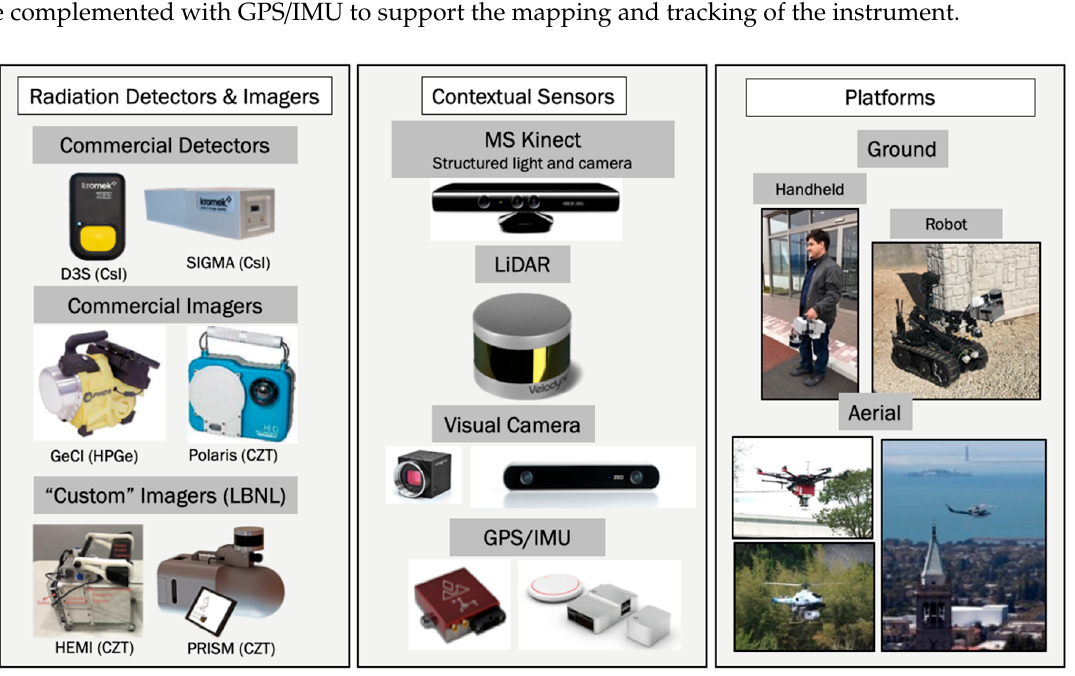
Figure 2. Examples of hardware components and platforms that can be used with the 3-D scene-data fusion (SDF) concept. Left: Commercial and custom-made radiation detection and imaging instruments can be integrated, depending on the specific requirements of the operations. These can be gamma-ray detection and imaging systems, as shown here, with neutron detectors or with combined systems, such as the recently developed Elpasolite scintillation detectors [39]. Middle: Contextual sensors based on structured light, light detection and ranging (LiDAR), or visual imagery can be used to map 3-D environments and to estimate the position and orientation of the instrument in this environment. Right: The combined radiation and contextual sensor system can be deployed on manned and unmanned ground and aerial platforms.